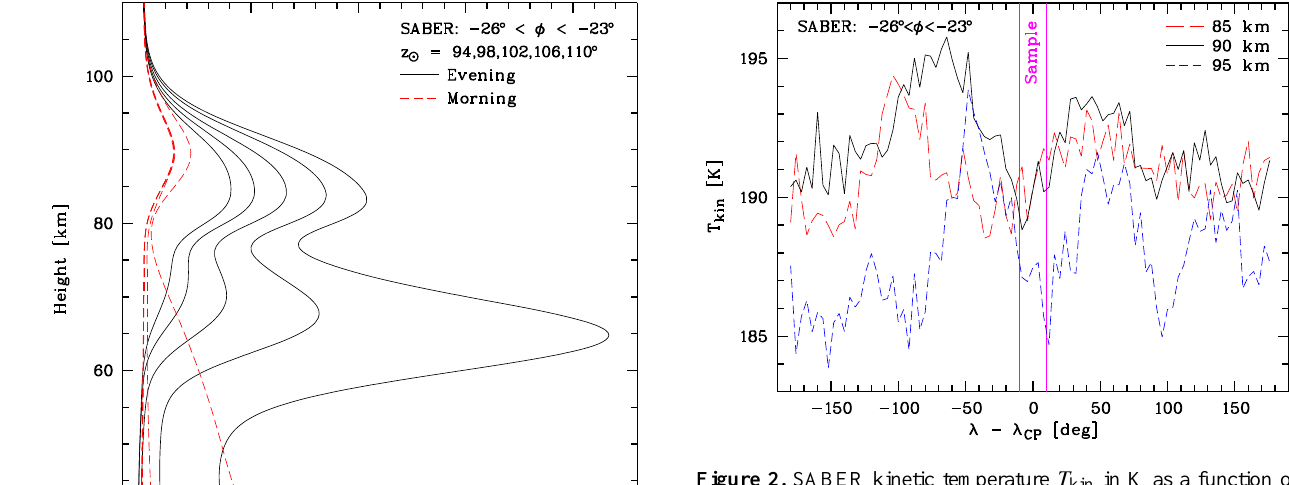
Figure 2. SABER kinetic temperature T kin in K as a function of the longitude distance to Cerro Paranal λ − λ CP in degrees for the altitudes 85 (long dashed), 90 (solid), and 95km (short dashed) and bin sizes of 4 ◦ and 1km. The averages were derived from SABER data for the latitudes between 23 to 26 ◦ S, the years from 2009 to 2013, and zenith distances of at least 100 ◦ . The final SABER sam- ple selection criterion | λ − λ CP | ≤ 10 ◦ is visualised by vertical